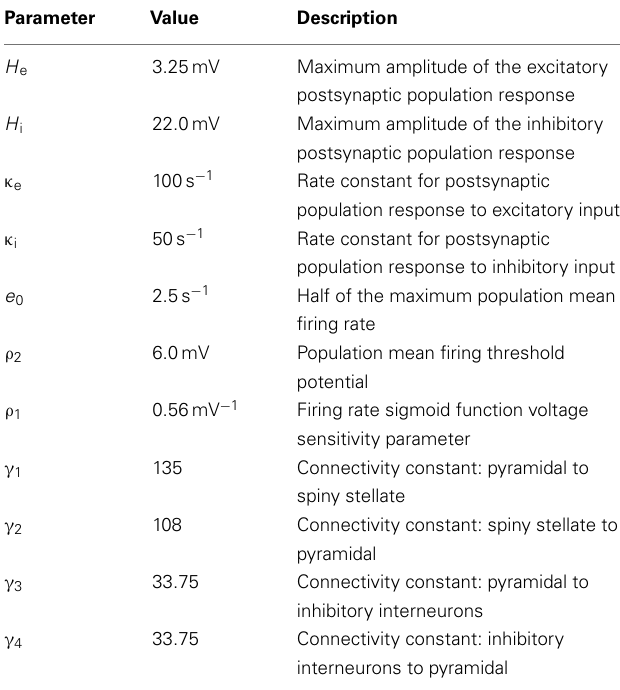
Table 1 | Jansen–Rit standard parameter